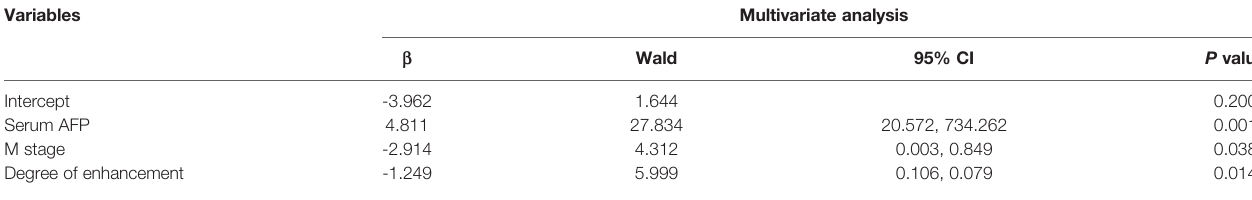
TABLE 3 | Multivariate analysis of clinicopathological characteristics and CT features of the HAS and non-HAS.